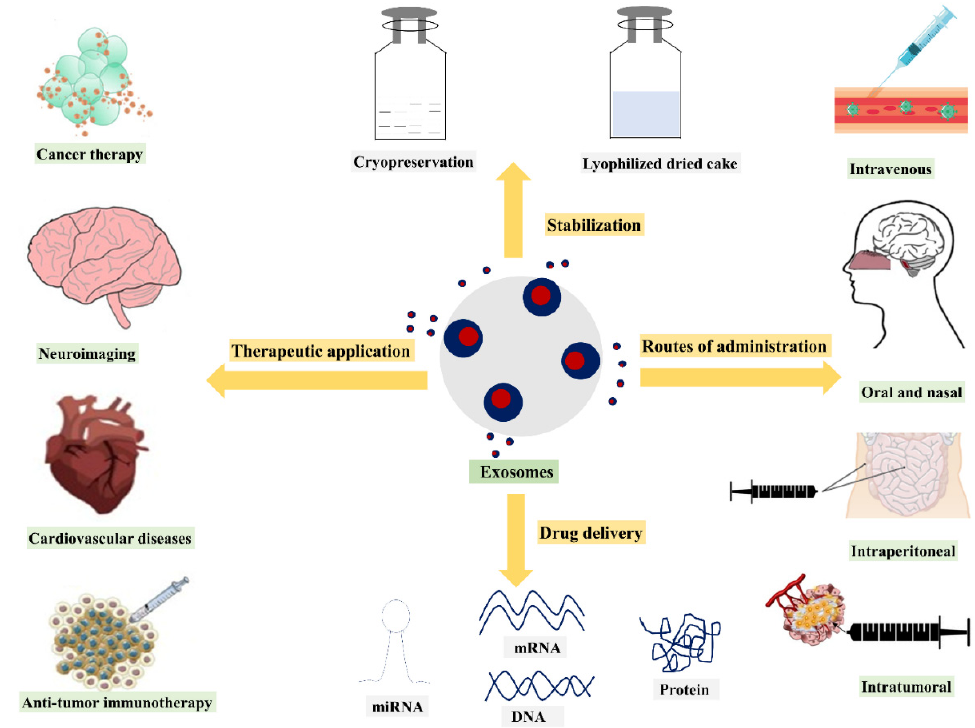
Figure 2. Overview of drug delivery and therapeutic applications of exosomes.